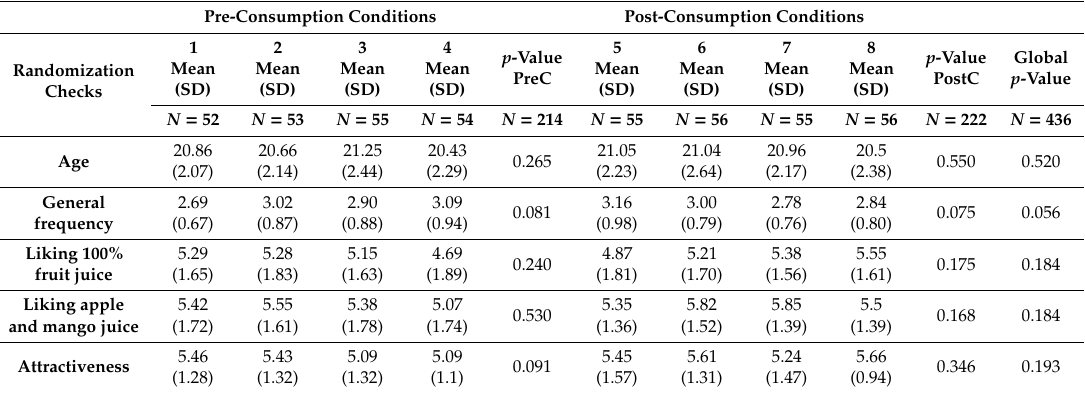
Table 2. Di ff erences across all conditions regarding randomization checks, including a di ff erentiation between the four non-tasting (pre-consumption, PreC) and the four tasting (post-consumption, PostC)